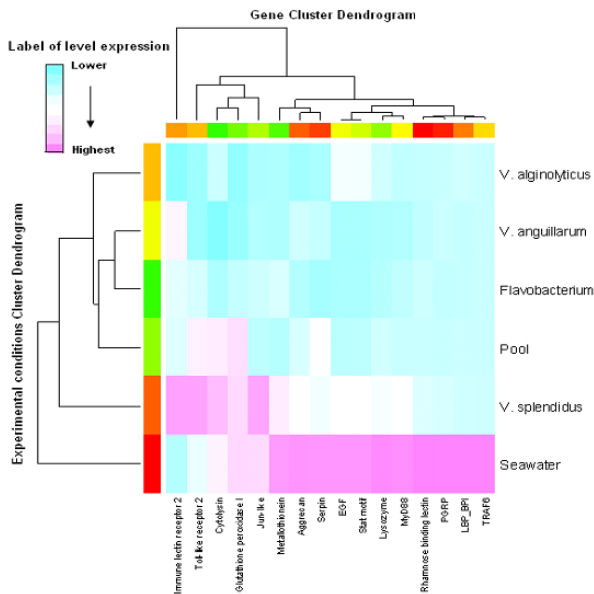
Fig.7 Fig. 7. Hierarchical Clustering Heatmap Plot of dendrograms using Unweighted Pair Group Method with Arithmetic Mean (UPGMA) method. The heatmap represents a grid of coloured points where each colour represents a level of gene expression (Fold change). The rows represent Experimental conditions ( V. alginolyticus , V. splen- didus , V. anguillarum , pool of Vibrios, Seawater and Flavobac- terium ) and the columns represent 16 genes analysed at 24h of in- fections. The grid coordinates correspond to the sample by gene combinations where the dark pink colour corresponds the highest expression and dark blue corresponds to the lowest